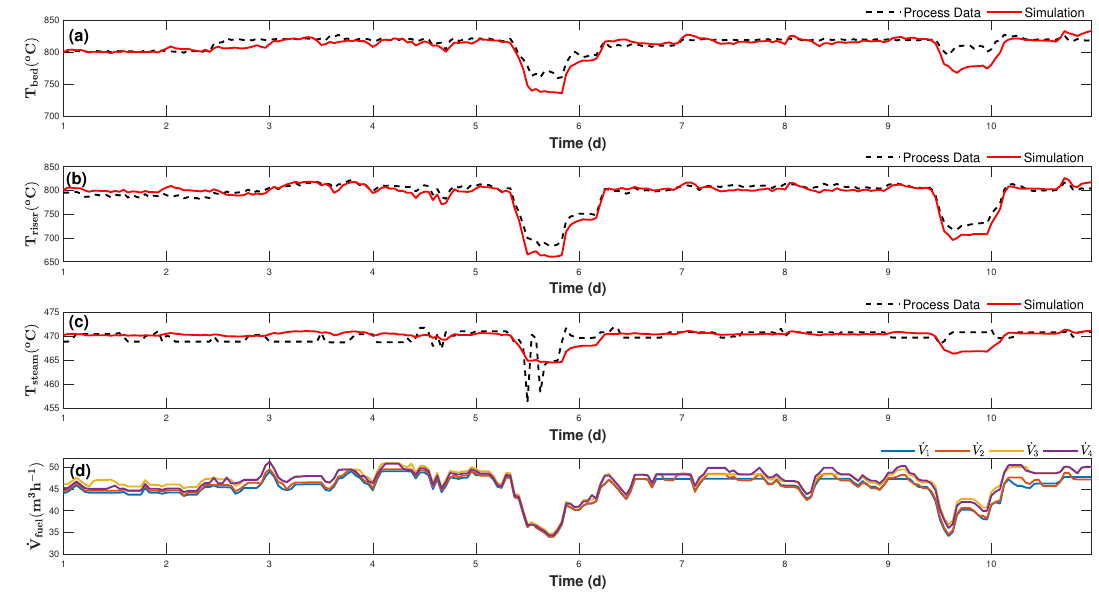
Figure 3. Simulation and actual temperature profiles for the boiler bed ( a ); riser ( b ); steam ( c ); and the volumetric flow rate measurement for the four fuel feeders ( d ).